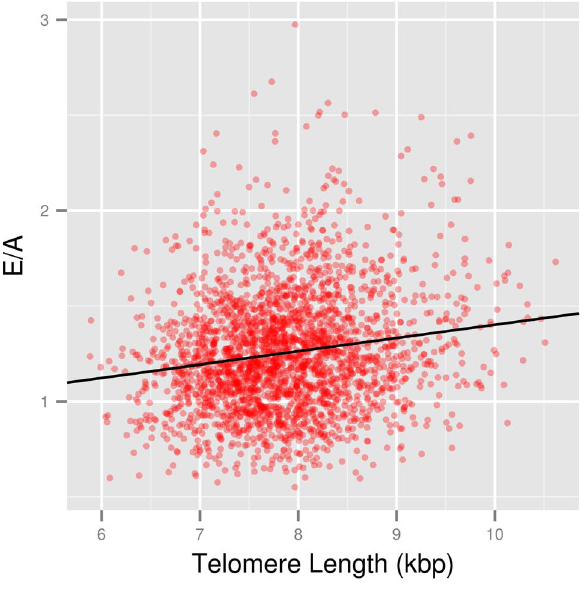
Fig. 1. TL , E/A. Scatterplot showing the unadjusted correlation between telomere length (TL) and the ratio of early (E) over late (A) mitral annulus movement speed (red) and the regression line (black). potential confounders: LV sphericity, oxidative stress (oxidized-LDL cholesterol,